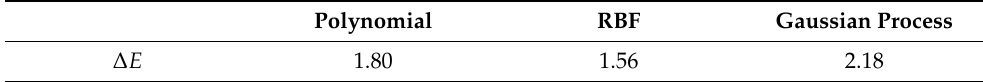
Table 3. Color difference of recent spectral reconstruction methods